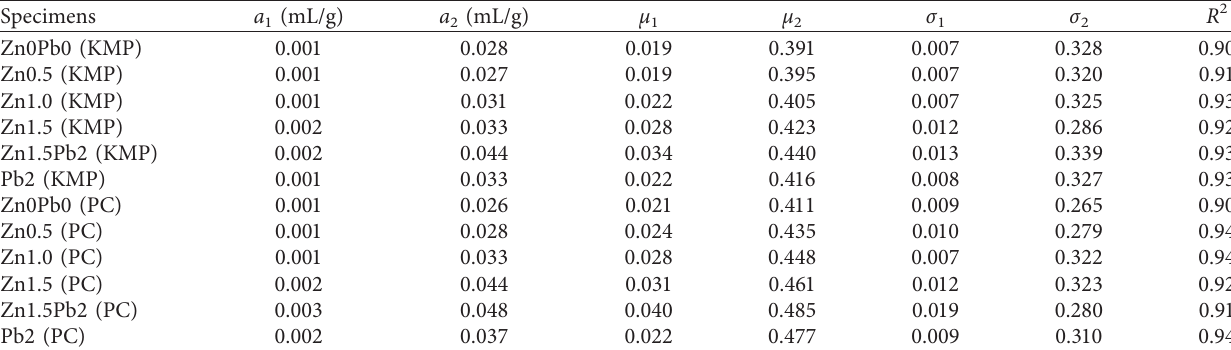
Table 4: Parameters obtained from the simulated PSD curves of KMP and PC stabilized soils (6% cement, 28days of curing) based on peak